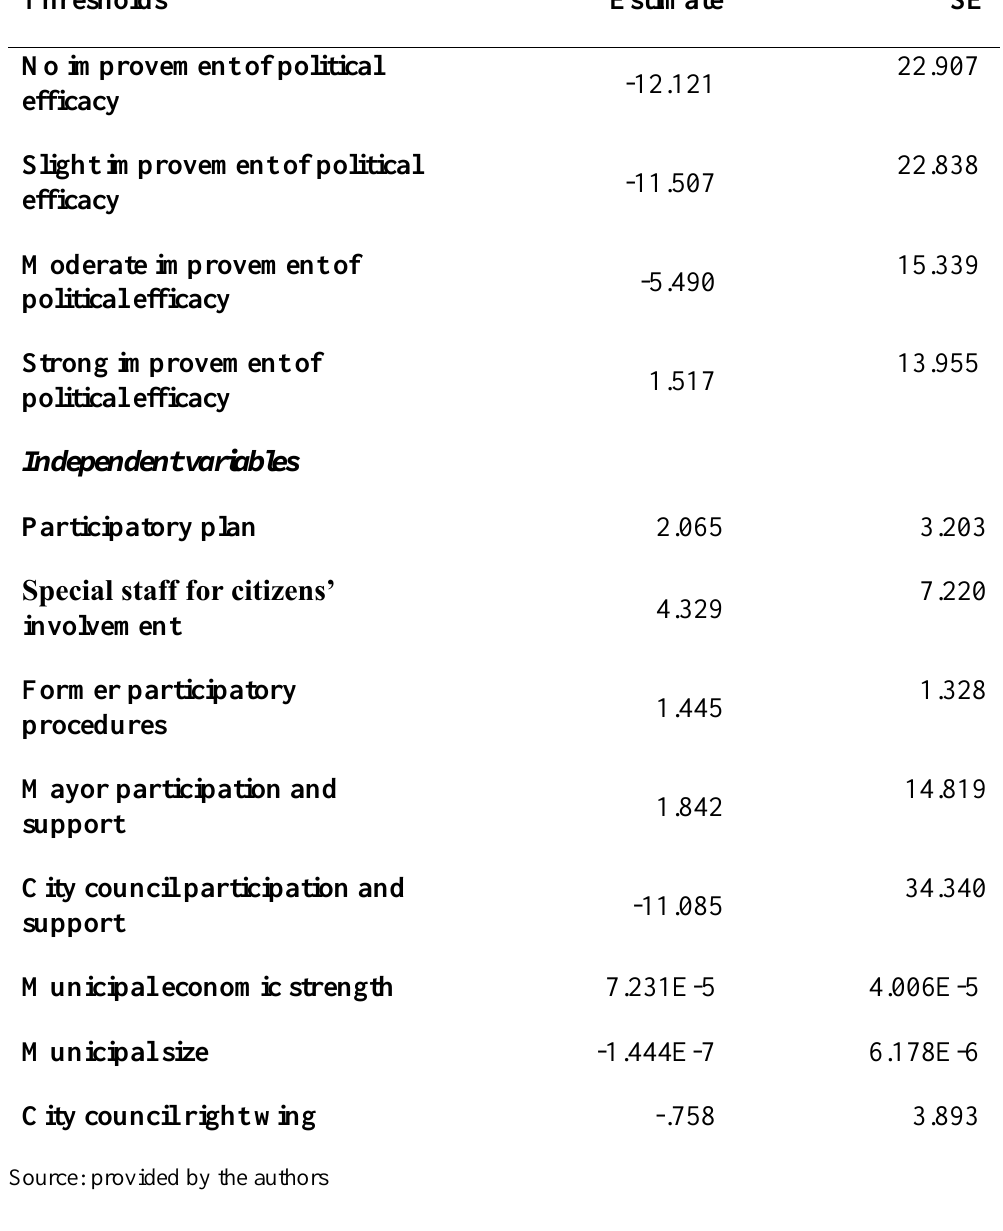
Table 4. Replication of statistical analysis in table 2 using